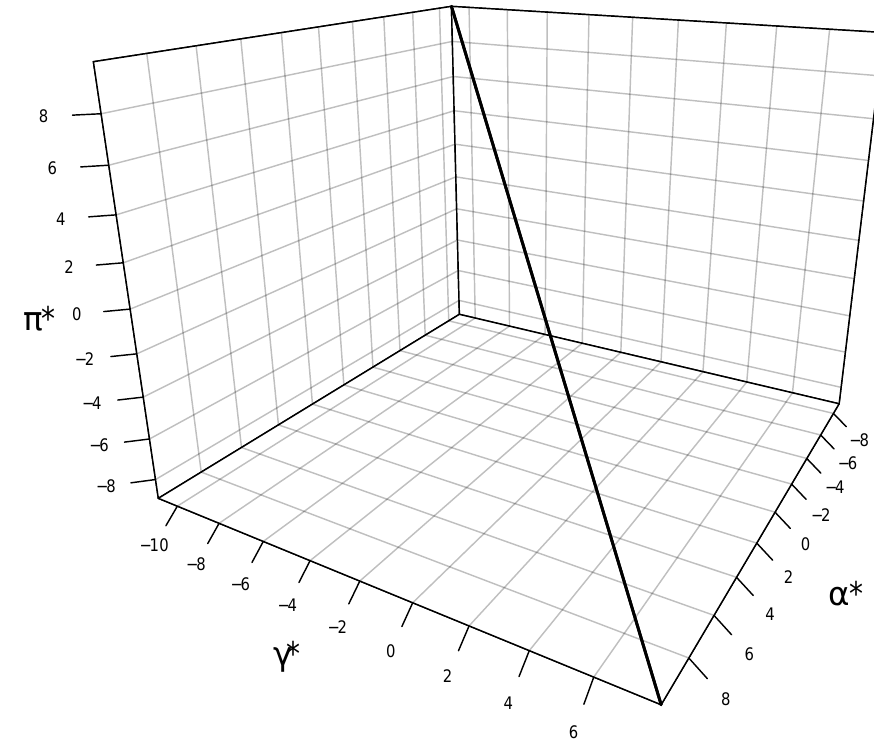
Figure 1: The canonical solution line. Notes: Data generated using values of α = 1.000, α 2 = 0.050, π = − 4.000, π 2 = − 0.250, γ = 6.000, γ 2 = 0.500, γ 3 = 0.100, and γ 4 = 0.050. Data consist of I = 8 age groups, J = 5 period groups, and I + J − 1 = K = 12 cohort